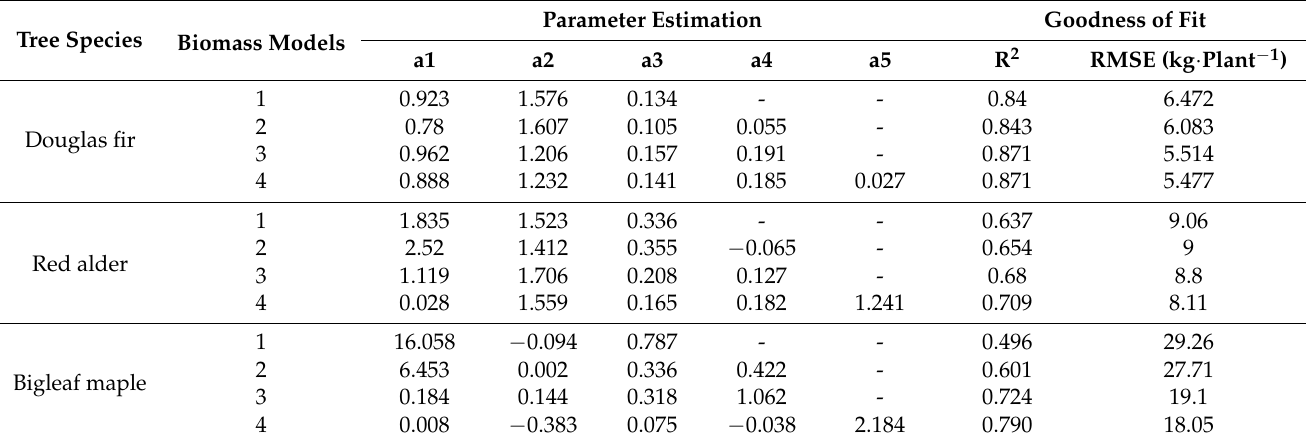
Table 6. Parameter estimation and goodness of fit of biomass